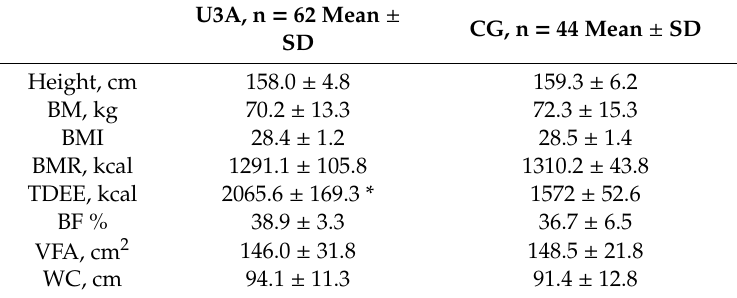
Table 1. Anthropometric characteristics of participants.